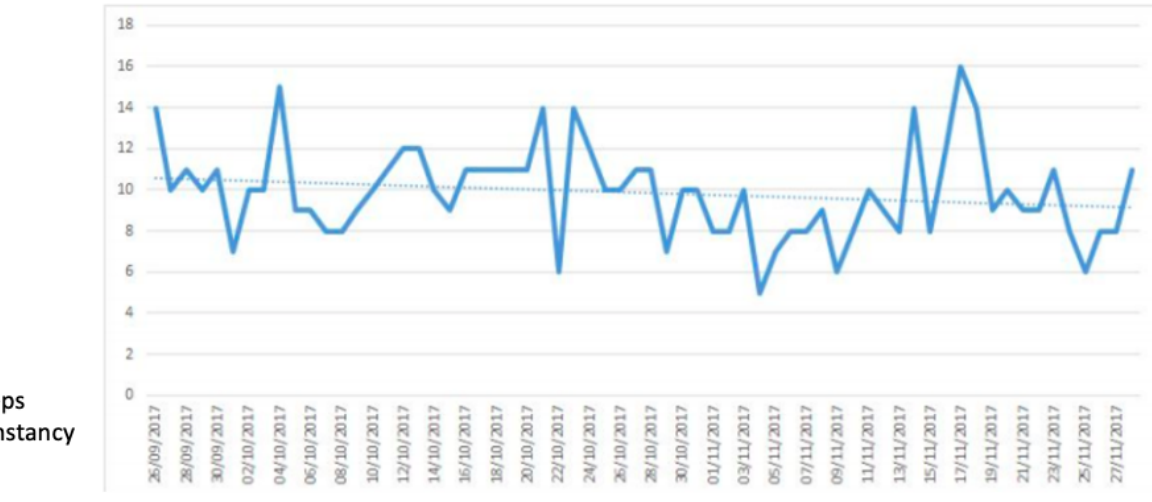
Figure 4. Daily steps